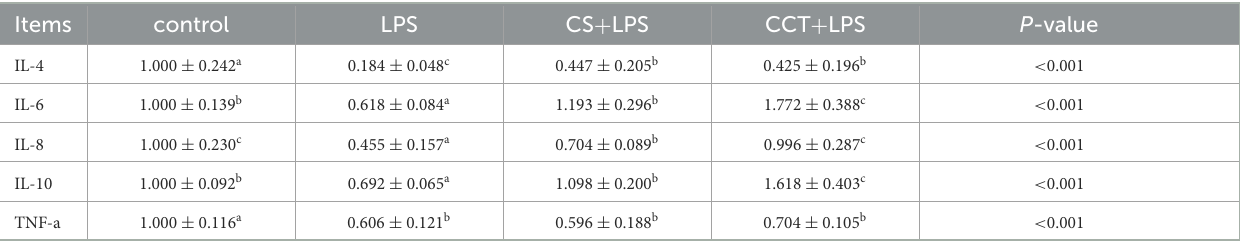
TABLE 7 Effects of CCT supplementation on the mRNA levels of immune related gene in mesenteric lymph nodes in piglets after LPS challenge.